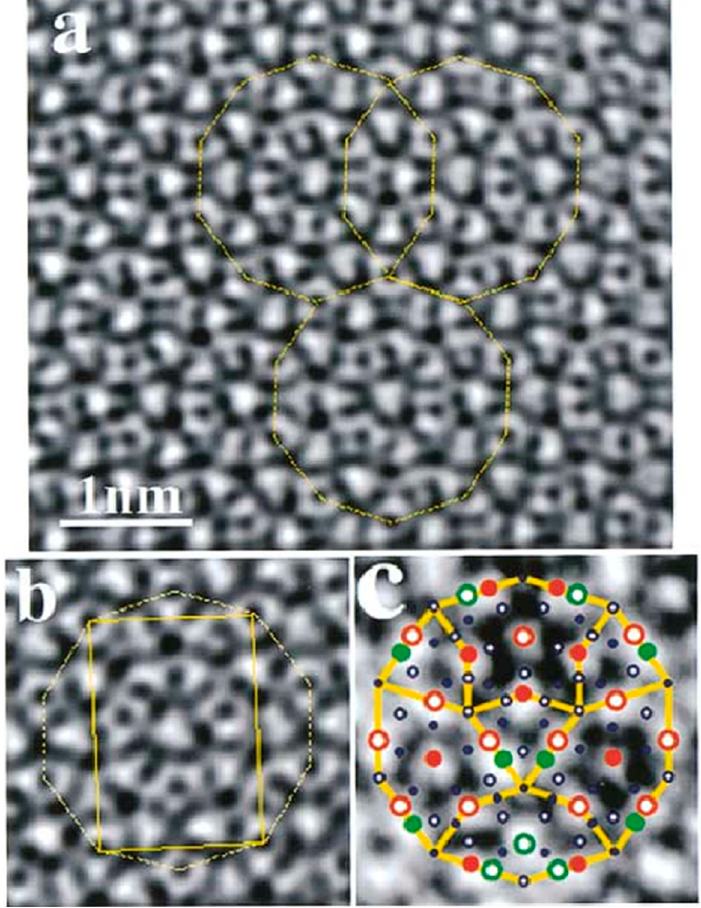
Figure 6. HRTEM images of decagonal Al 72 Ni 20 Co 8 with the background subtracted: ( a ) Gummelt tiling; ( b ) a representative decagonal cluster; and ( c ) the comparison between the mirror-symmetry model and the rectangular region in ( b ) (reproduced from reference [91] with permission).